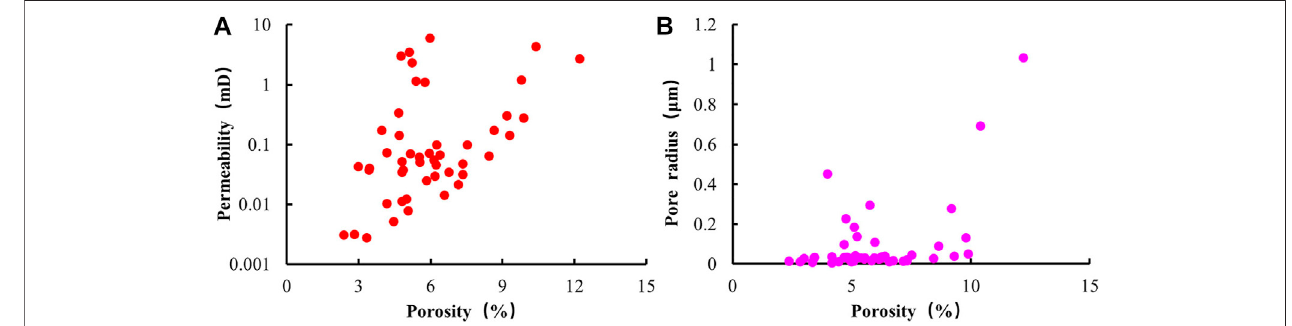
FIGURE 7 | (A) The relationship between porosity and permeability; (B) The relationship between porosity and pore size.